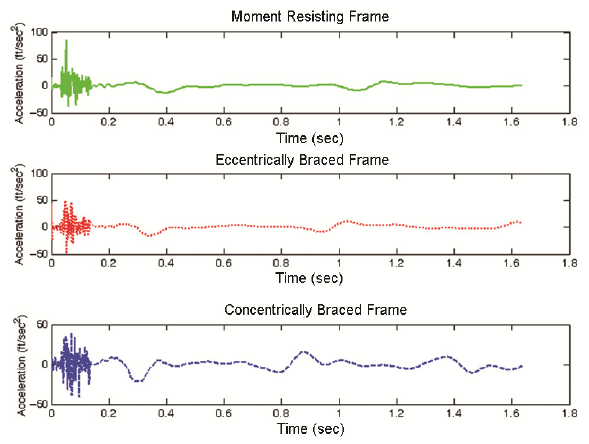
Fig. 13. Roof acceleration under 2-K (8.9 kN) blast